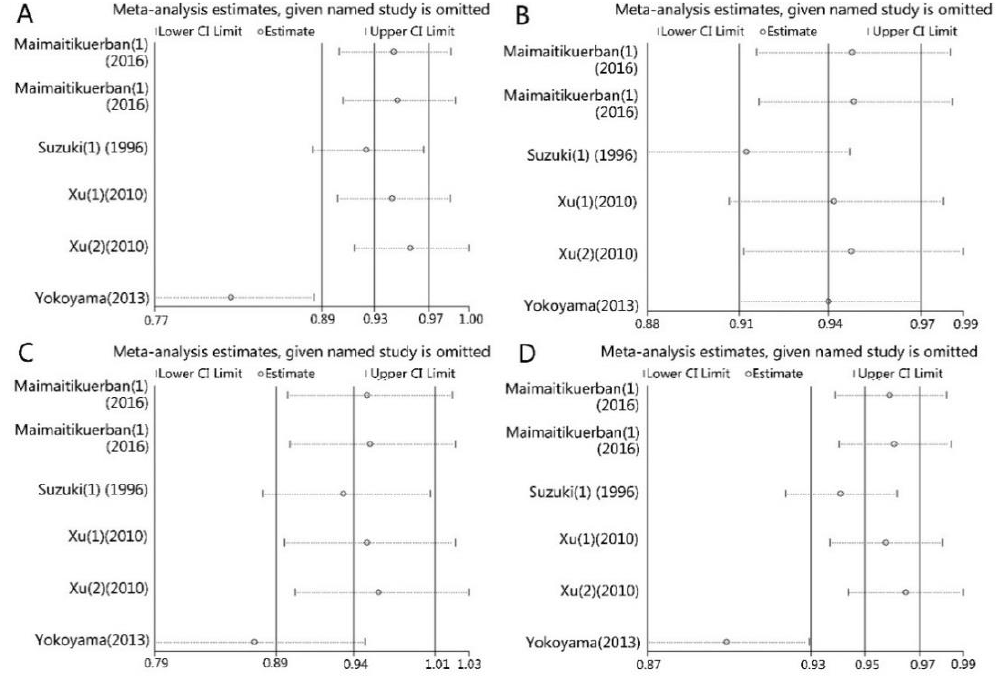
Figure 4. Sensitivity analysis of the influence of each study on pooled ORs and 95% CIs in different genetic models for associations of ALDH2 rs671 and DM. ( A ) *1/*1 vs. *1/*2; ( B ) *1/*1 vs. *2/*2; ( C )